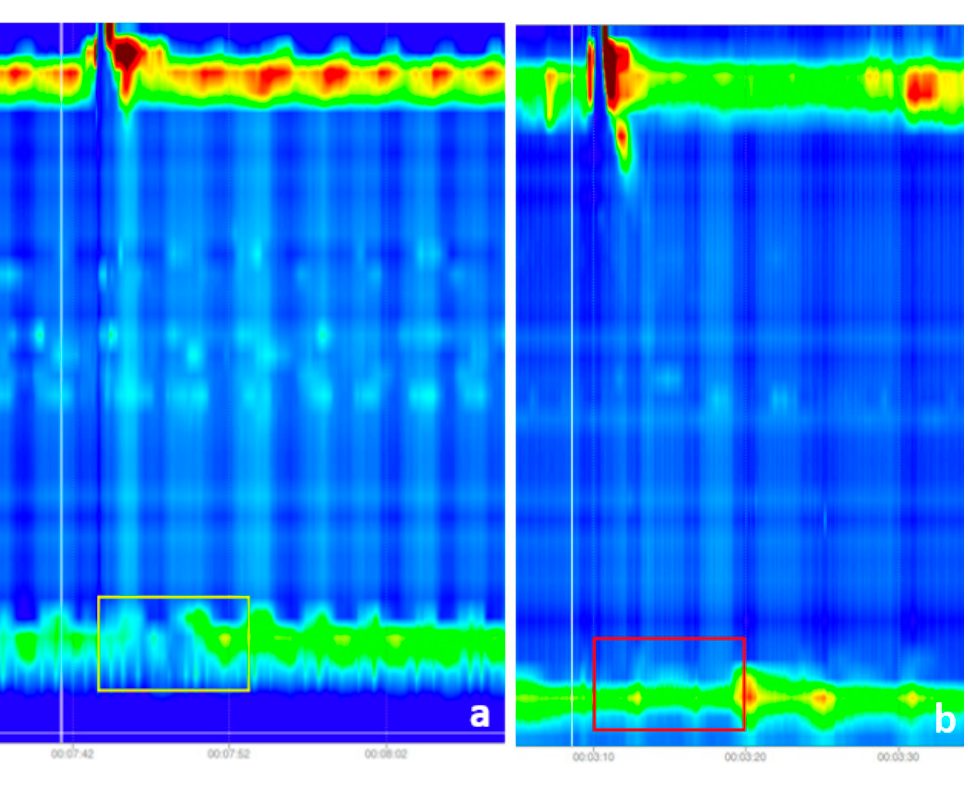
Figure 1. ( a ) Swallow with failed peristalsis and normal relaxation of the lower esophageal sphincter (LES), as shown by the color shift (caused by the pressure drop)—the area of focus is the yellow rectangle; ( b ) Swallow with failed peristalsis and lack of LES relaxation (there was no color change, and the measured IRP was over the cutoff—red rectangle). Both datasets included photos of moist swallows with simply a white vertical line (placed during the recording) indicating the test swallow. The program enables the storing of photos representing 60 s of the recording. We saved the photographs with the white mark located around the image’s